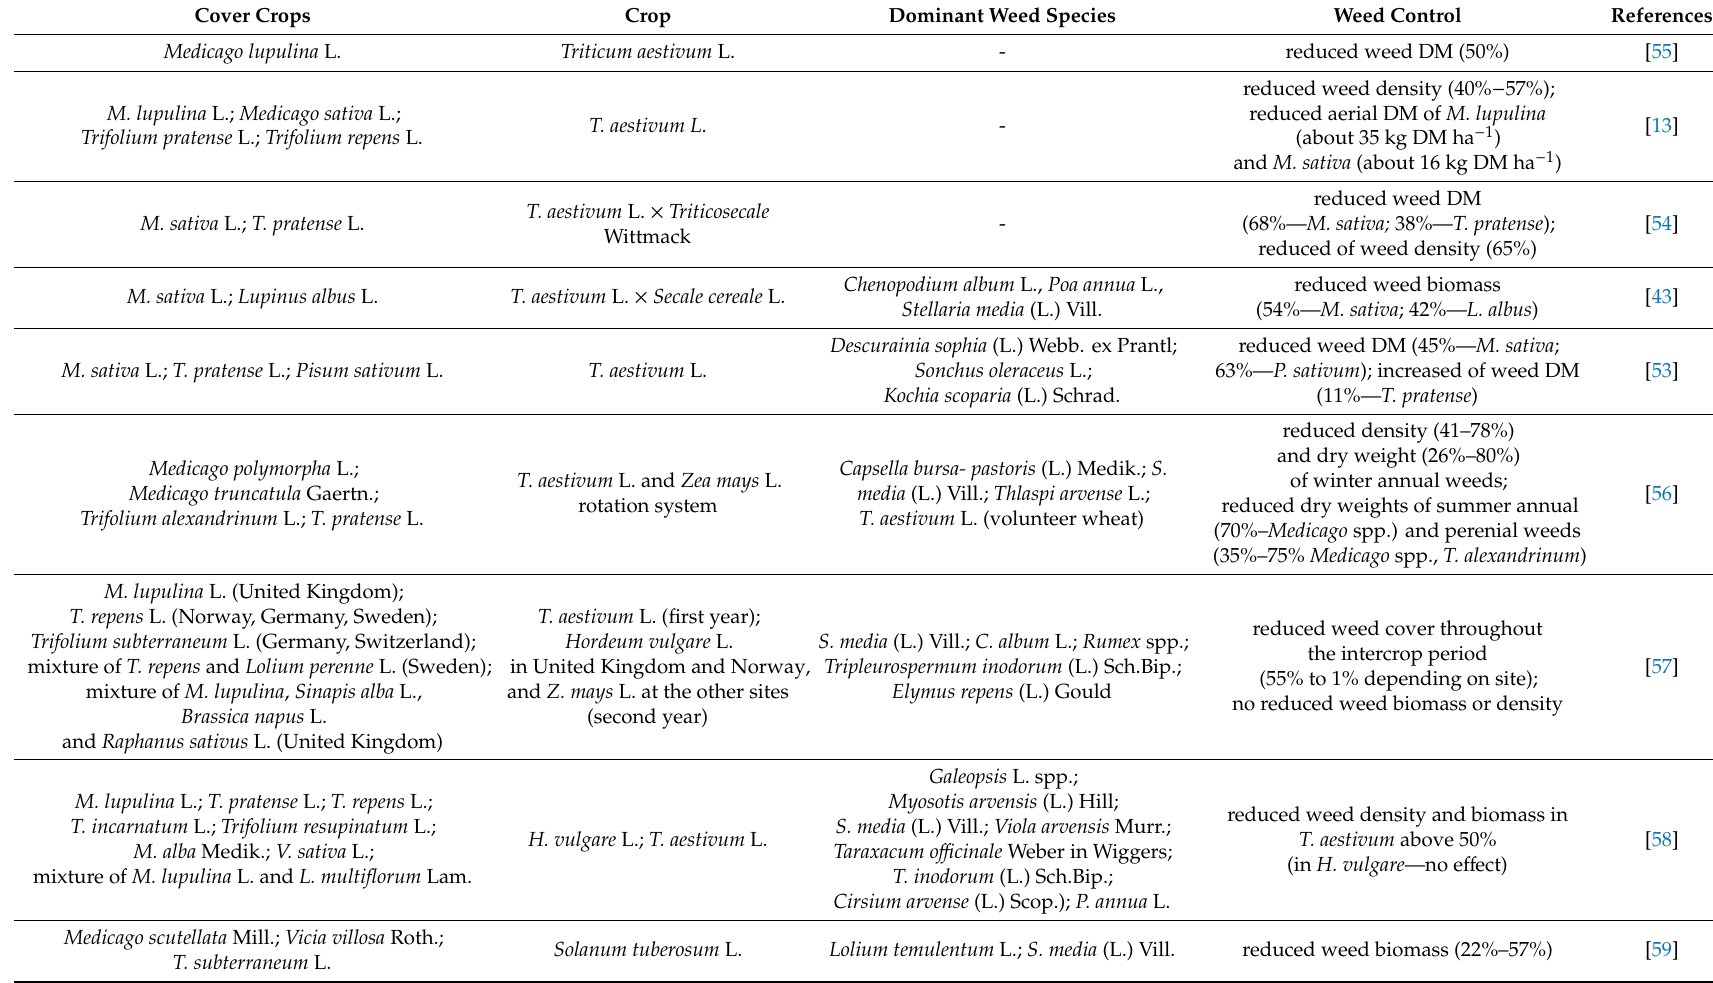
Table 1. E ff ect of di ff erent species of legume CCs on the reduction of weed infestation. Cover